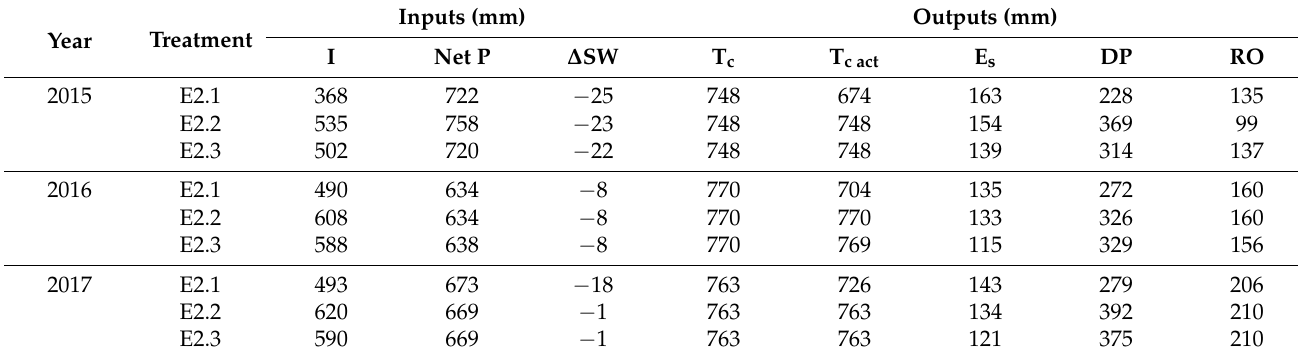
Table 12. Components of the annual water balance relative to the E2 growing seasons.